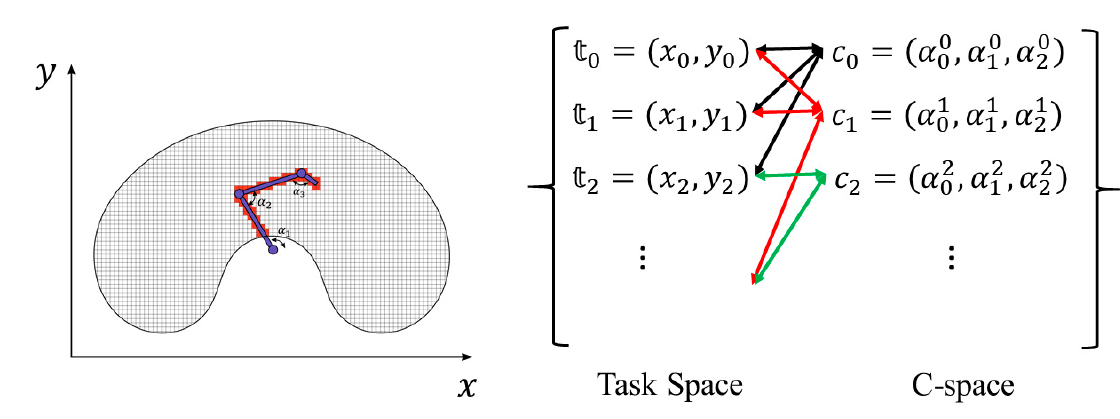
Figure 2. One example of a bidirectional projection between the task space and the configuration space, both of which are discretized. For each reachable configuration of the robot, its occupied cells (in red) in task space can be calculated and stored